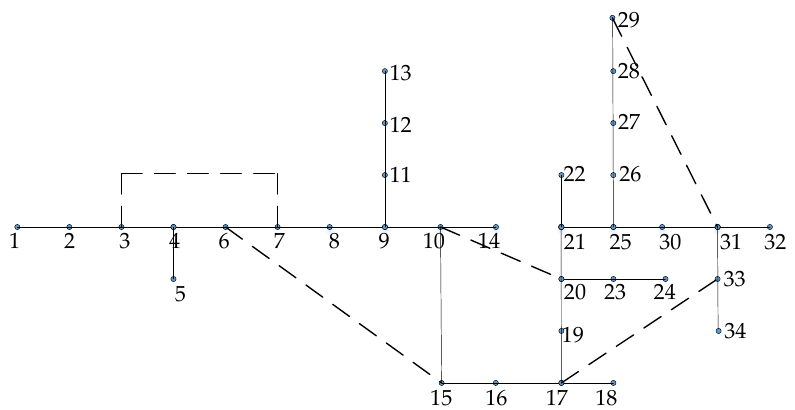
Figure A1. IEEE 34 bus system.